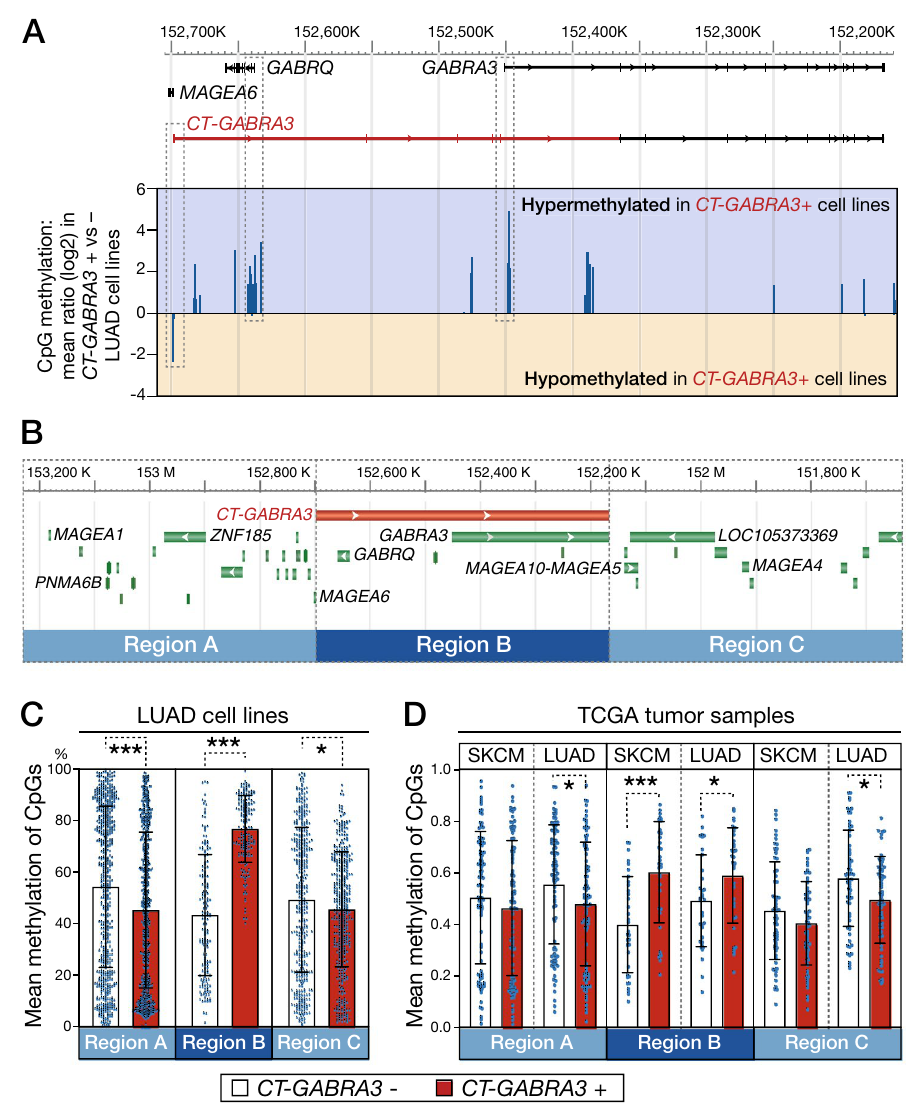
Figure 2. CT-GABRA3 expression correlates with hypermethylation of CpGs embedded within its entire transcription unit. ( A ) Using Methyl-seq data from DBTSS, CpG methylation ratios between CT-GABRA3 - positive and -negative LUAD cell lines were calculated. Values for all available CpGs within the GABRA3 locus are represented (log2). Positive or negative values indicate hypermethylation or hypomethylation, respectively, of the CpG in CT-GABRA3 -positive versus -negative LUAD cell lines. Hypermethylation includes CpGs within the promoter of GABRQ . ( B ) Schematic representation of the three defined 530 kb genomic segments, corresponding to the CT-GABRA3 transcription unit (Region B ), and the two neighboring segments (Regions A and C ). ( C ) LUAD cell lines were divided in two groups, according to CT-GABRA3 expression status, and Methyl-seq datasets from DBTSS were used to determine mean methylation levels (% methylation) of all CpGs contained in each of the three genomic regions defined in ( B ). ( D ) A similar analysis, based on Infinium methylation data, was performed in melanoma (SKCM) and lung adenocarcinoma (LUAD) tissue samples from TCGA. * and *** Welch’s t-test, p -value < 0.05 and < 0.001,